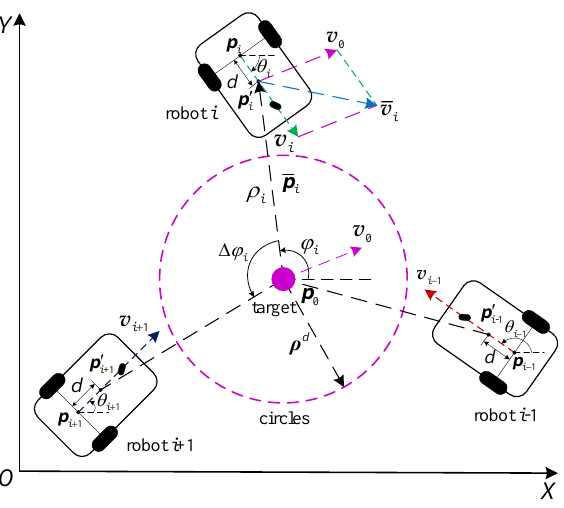
Figure 1. Illustration of the cooperative target